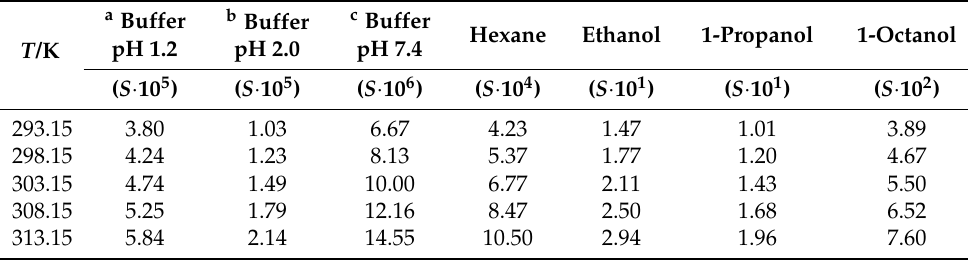
Table 2. Temperature dependences of solubility ( S , mol · L − 1 ) for IVZ in the selected solvents at pressure p = 0.1 MPa.